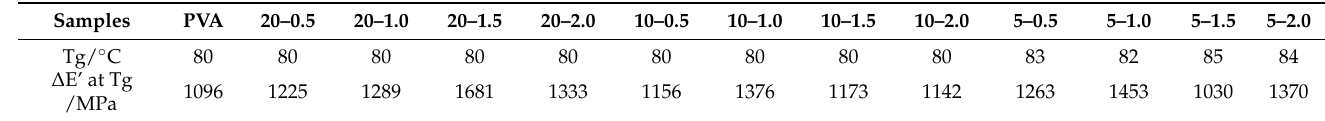
Table 4. The DMA data of PVA and PVA/CNF composites as a function of the CNF content.